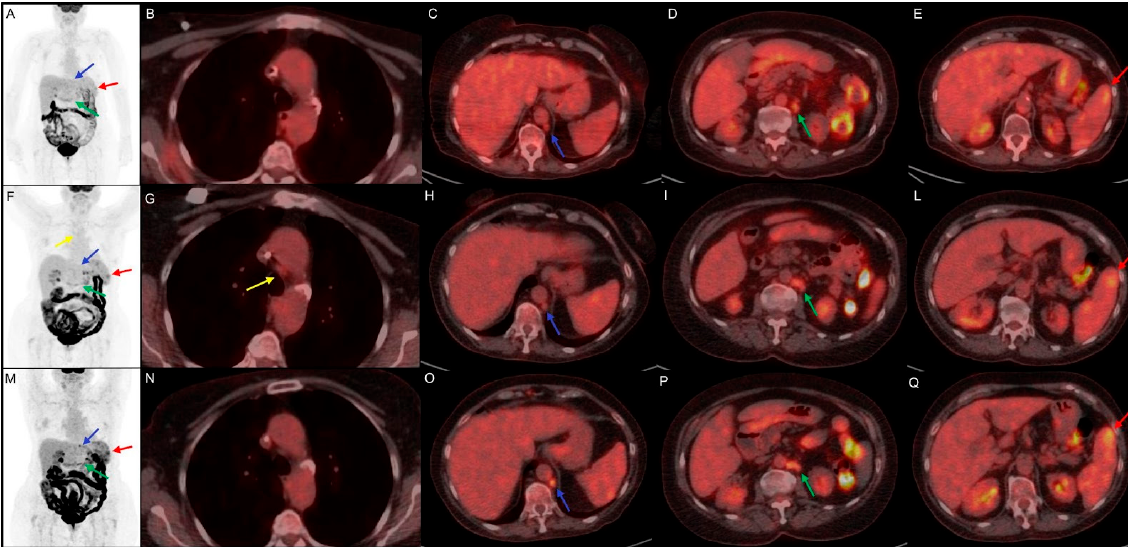
Figure 3. Clinical case of a 75 year-old female with history of classic Hodgkin Lymphoma firstly diagnosed in August 2014. She underwent chemotherapy with ABVD and, in September 2017, with brentuximab and R-bendamustine for disease relapse. In June 2019, the disease persistence induced hematologists to choose an off-label treatment with nivolumab. ( A – E ) 18F-FDG PET/CT performed before the start of immunotherapy, documented disease localized in para-aortic (blue arrow, SUVmax 4.5) and lombo-aortic (green arrow, SUVmax 5.5) lymph nodes and splenic lesions (red arrow, SUVmax 4.7). ( F – L ) Early 18F-FDG PET/CT performed 3 months after the start of the immunotreatment, indicate a dissociated response with decreasing SUVmax in para-aortic (blue arrow, SUVmax 2.5) and lombo-aortic (green arrow, SUVmax 4.5) lymph nodes but increased 18F-FDG uptake in splenic lesions (red arrow, SUVmax 5.7) and the appearance of a mediastinal adenopathy (yellow arrow, SUVmax 2.4). ( M – Q ) Interim 18F-FDG PET/CT, performed 6 months after the start of nivolumab, documented an increased uptake in para-aortic (blue arrow, SUVmax 6.9), lombo-aortic (green arrow, SUVmax 5.3) lymph nodes and in splenic lesions (red arrow, SUVmax 6.5). The mediastinal adenopathy previously detected showed no FDG uptake.